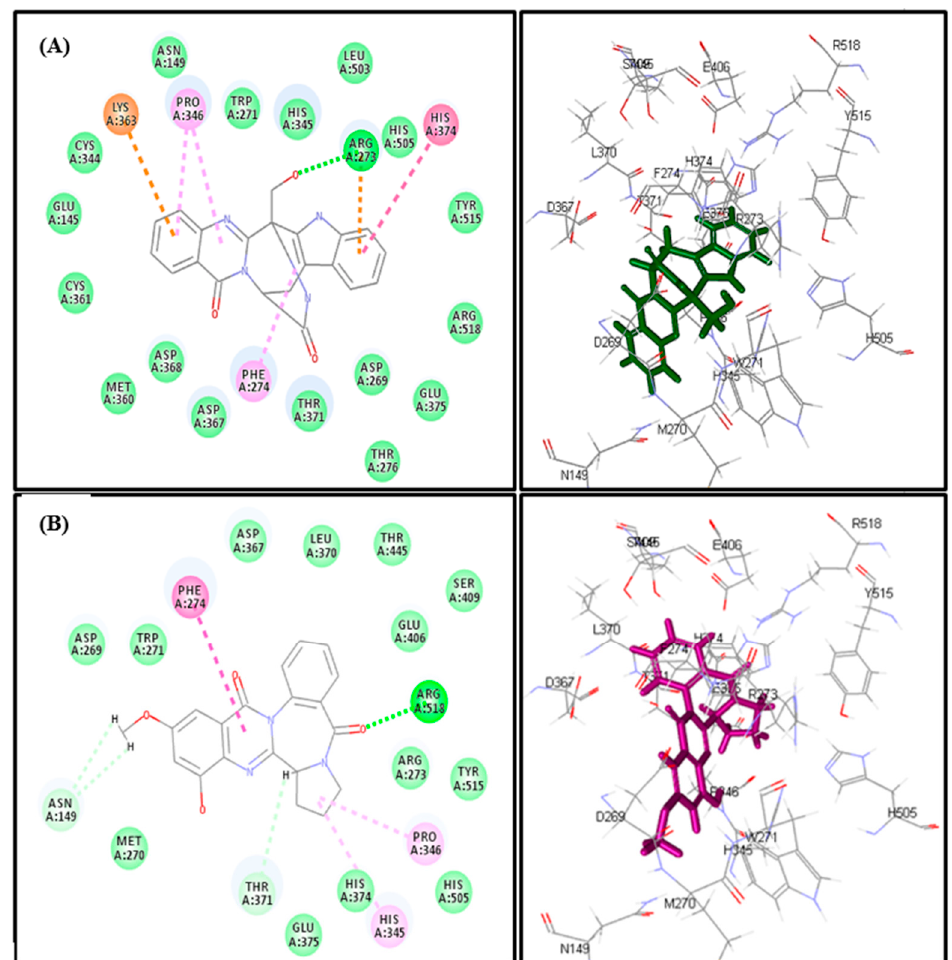
Figure 12. 2D and 3D binding mode of Fumigatoside E ( 28 ) ( A ) and Aspergicin ( 150 ) ( B ) in the binding site ACE2.